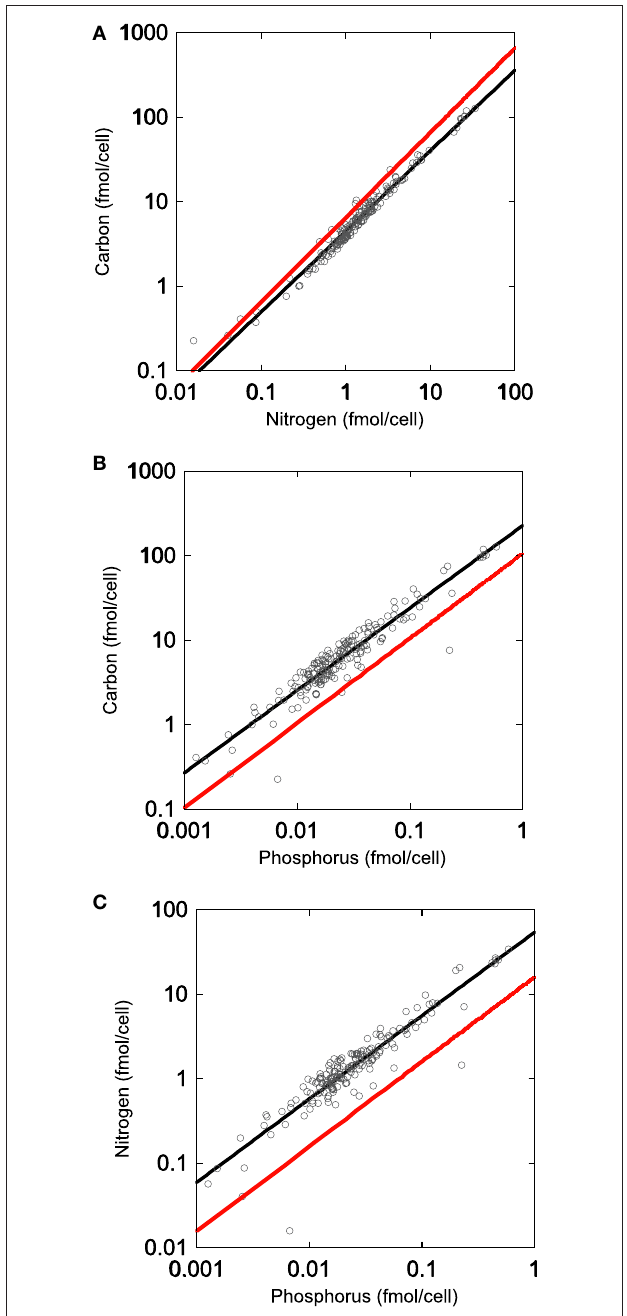
Figure 3 | regressions of organic carbon, nitrogen, and phosphorus content in Lake Myravatnet (Bergen, Norway) using X-ray microanalysis: (A) C vs. N, (B) N vs. P, and (C) C vs.